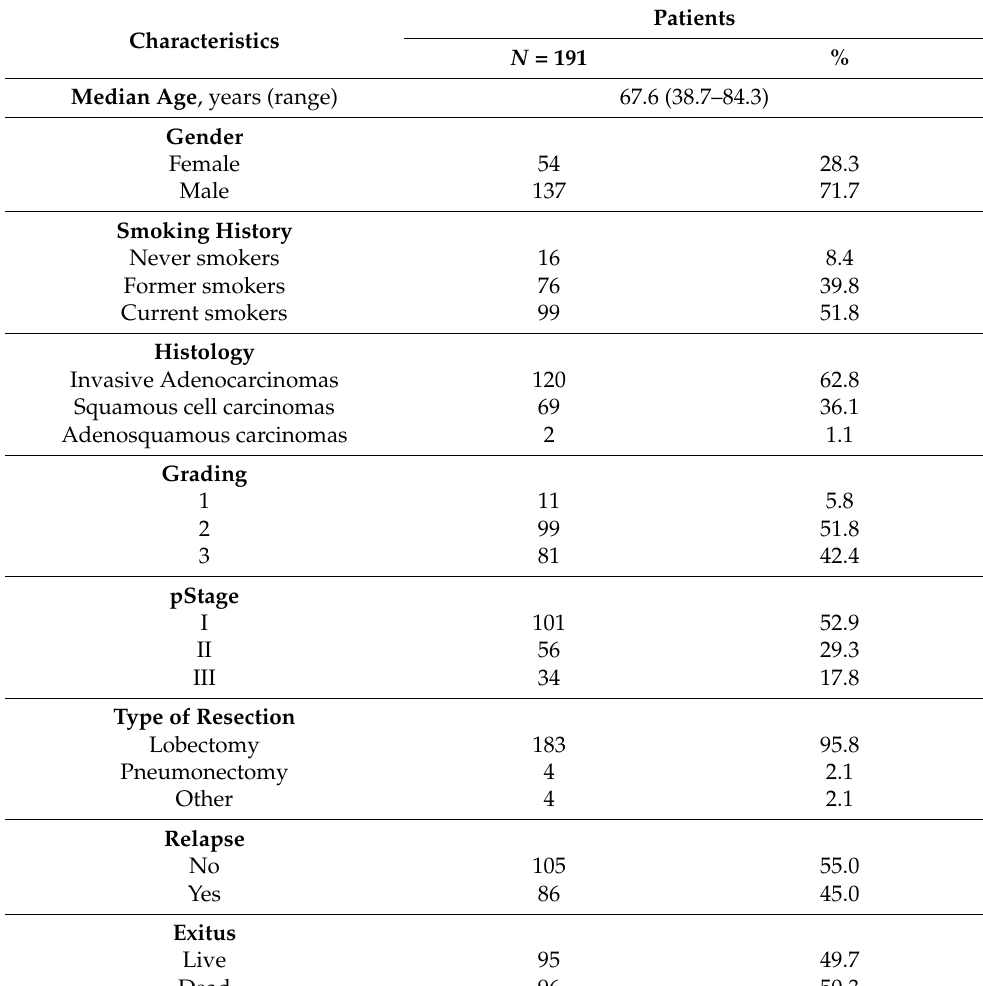
Table 1. Patient